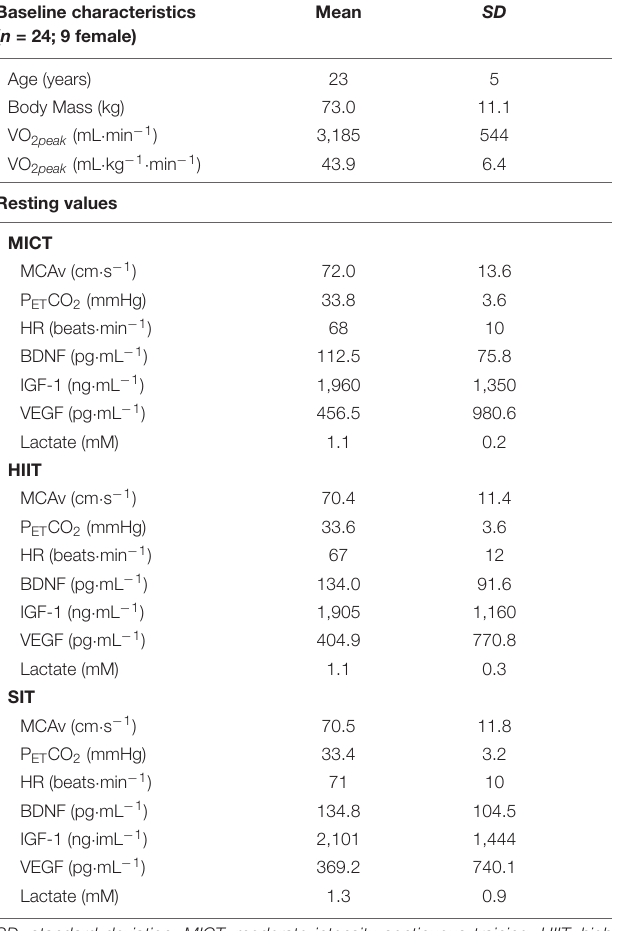
TABLE 1 | Baseline characteristics and resting values for participants taking part in three different exercise protocols. Baseline characteristics ( n = 24; 9 female)